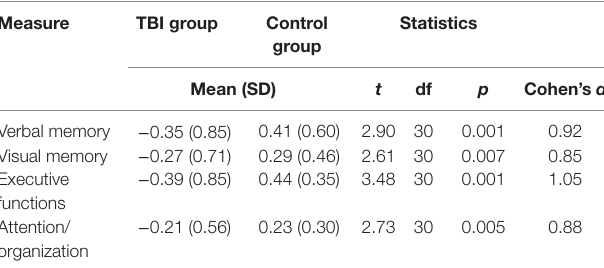
TaBle 2 | Performance on neurocognitive constructed